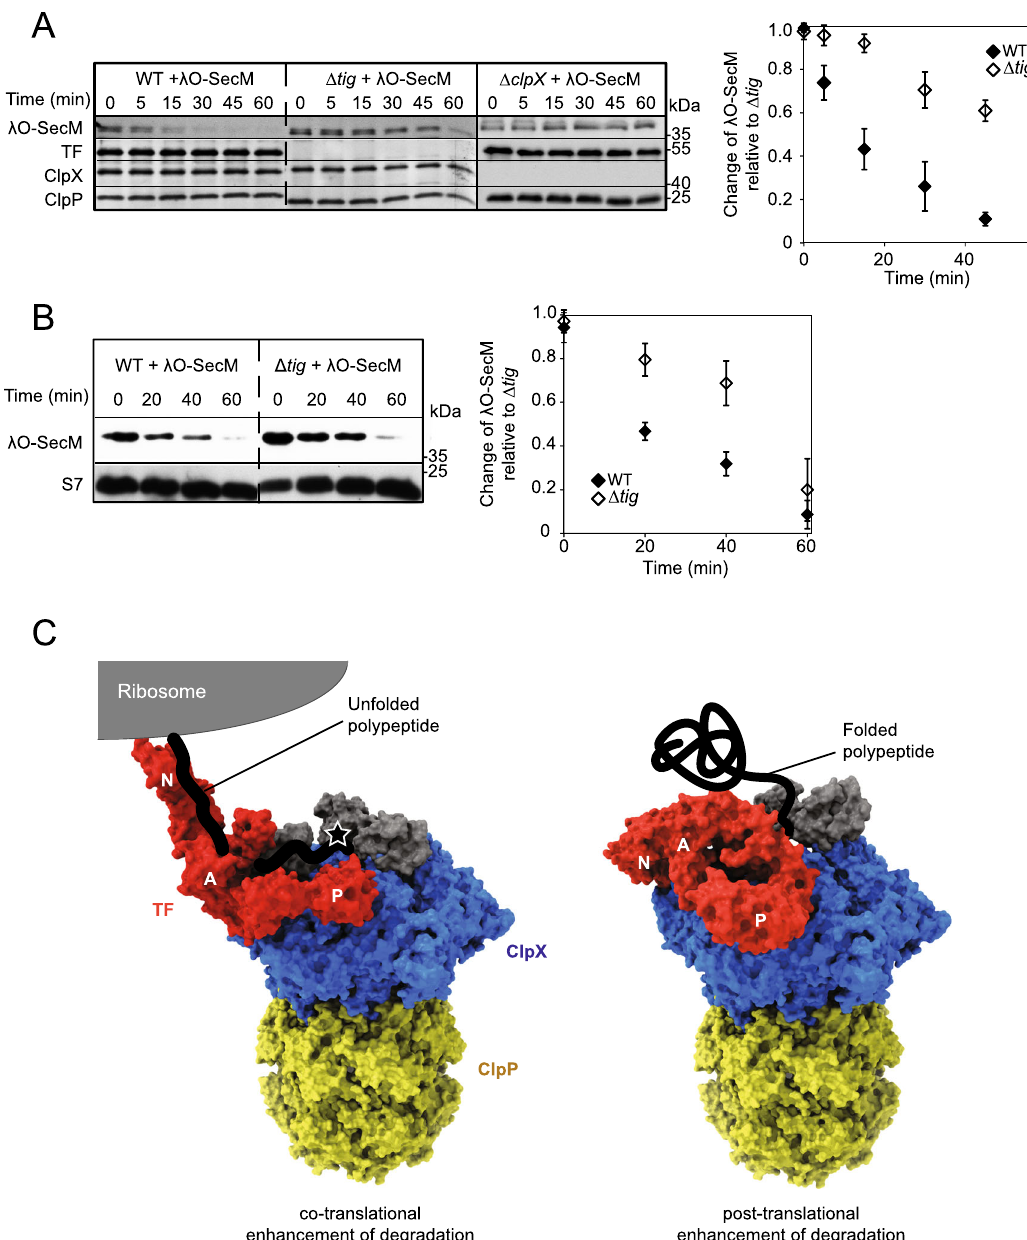
Fig. 7 TF enhances the ClpXP-dependent degradation of λ O in a cotranslational manner. A Western blot analysis showing λ O-SecM degradation. λ O- SecM was induced from a plasmid in different strain backgrounds and then translation was inhibited. Quanti fi cation of the λ O-SecM band as a function of time is shown on the right based on three experimental repeats. Error bars show the standard deviation for each time point. B Same experiment as in ( A ) but shown is the amount of λ O-SecM in the ribosomal fraction obtained after separation of cell lysates on sucrose cushions. Samples with equal OD 260 were loaded to ensure that each point contained equal amount of ribosomal material as indicated by the western blot for S7 of the small ribosomal subunit. Quanti fi cation of the λ O-SecM band as a function of time is shown on the right based on three experimental repeats. Error bars show the standard deviation for each time point. C Cartoon model of the role of TF in the ClpXP-dependent degradation of newly synthesized proteins in a co-translational and post-translational context (see text for details). The star represents the ClpX recognition sequence in the substrate. Source data are provided as a Source Data fi